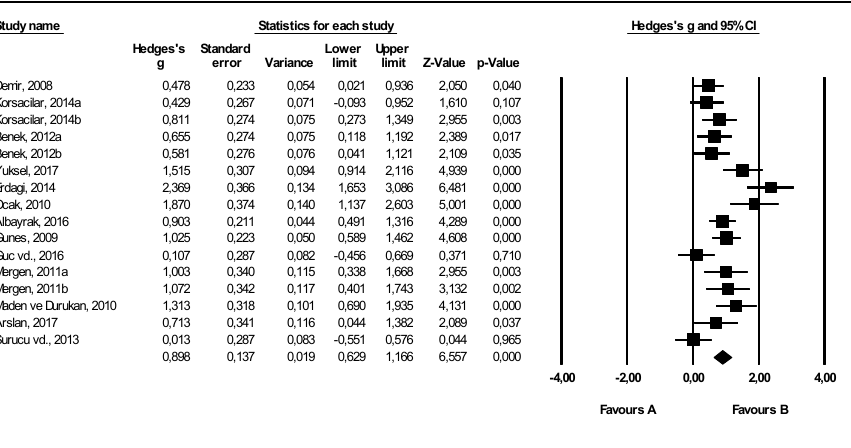
Absence Heterogeneity Hypothesis